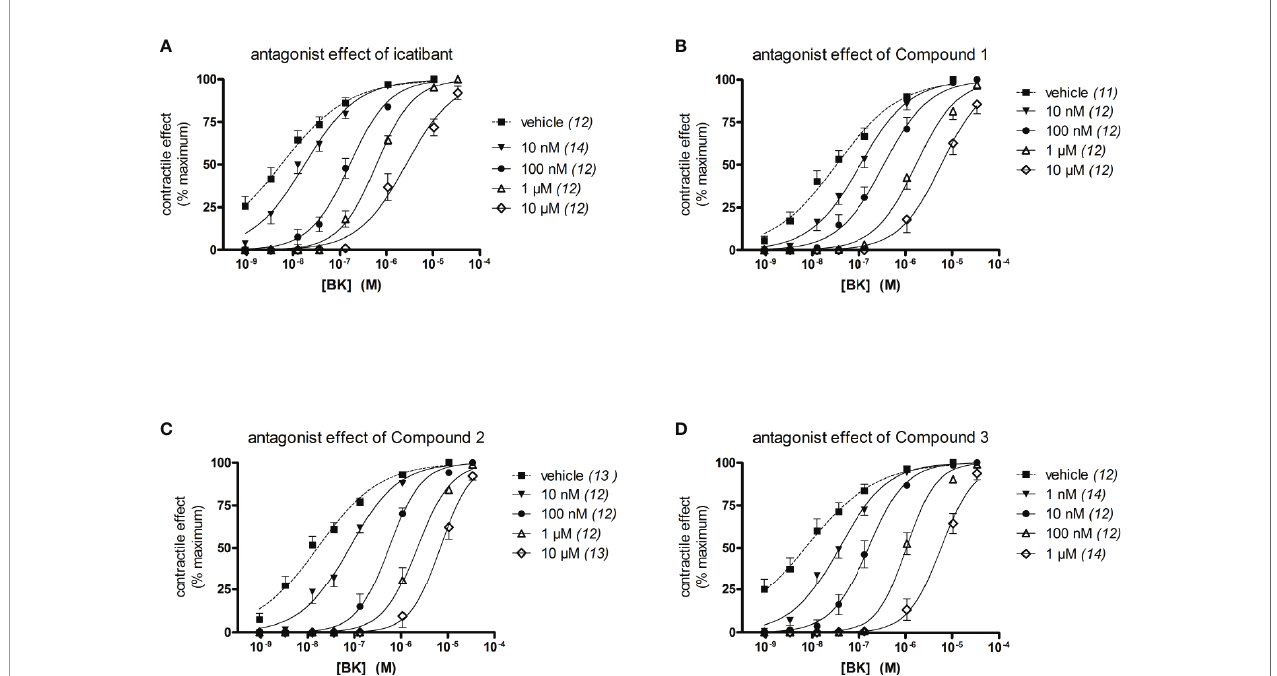
FIGURE 3 | Effect of four B 2 receptor antagonists on BK-induced contraction in the human isolated umbilical vein. The identity of the tested antagonist is icatibant (A) , Compound 1 (B) , Compound 2 (C) and Compound 3 (D ). Values are the means ± S.E.M. of the number determinations indicated between parentheses. For the sake of clarity, several error bars below or above the average values have been omitted.